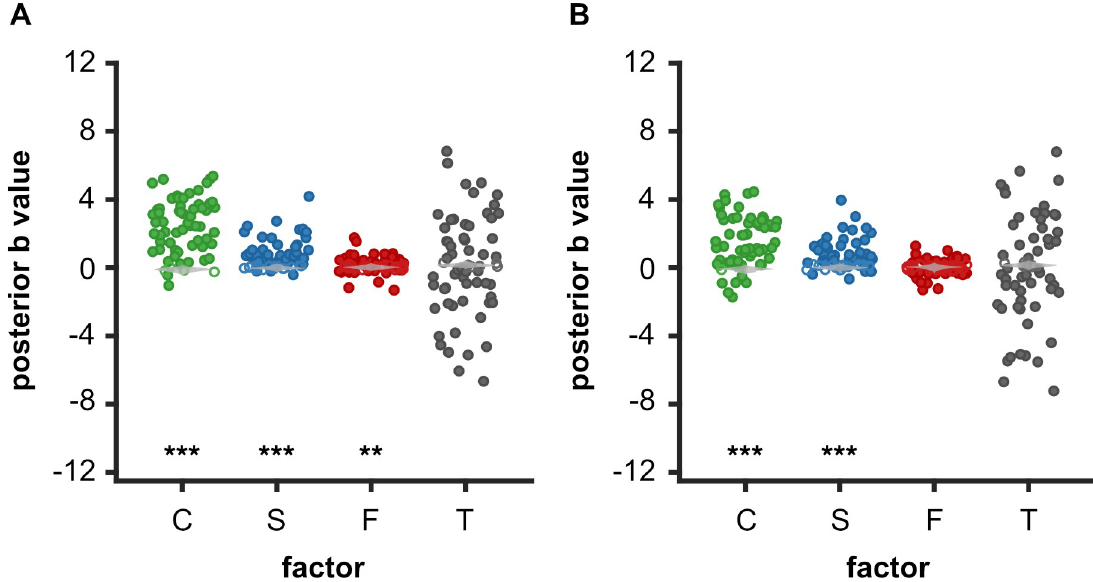
Fig 5. Model-based assessment of whether values are influenced by past actions. Posterior estimates of bias parameters were obtained using (A) BMA on all models (H0-H2) of ratings only (B) BMA on all extended models (H0-H3) of both rating and action-related variables. Bias parameters are the weights assigned to choices (C, green), success (S, blue), force (F, red) and time (T, grey) in equations used to update ratings (H1-H2) or values (H3). Each dot represents one subject. The violins (in light grey) represent the bootstrap distribution of the respective posterior parameters under the null hypothesis (see Supplementary Material). Hollow dots represent subjects for whom the posterior estimate falls within the 95% credible interval of the null distribution. Significant deviation from the null (see Supplementary Material) is indicated as following: �� p < 0.01; ��� p <